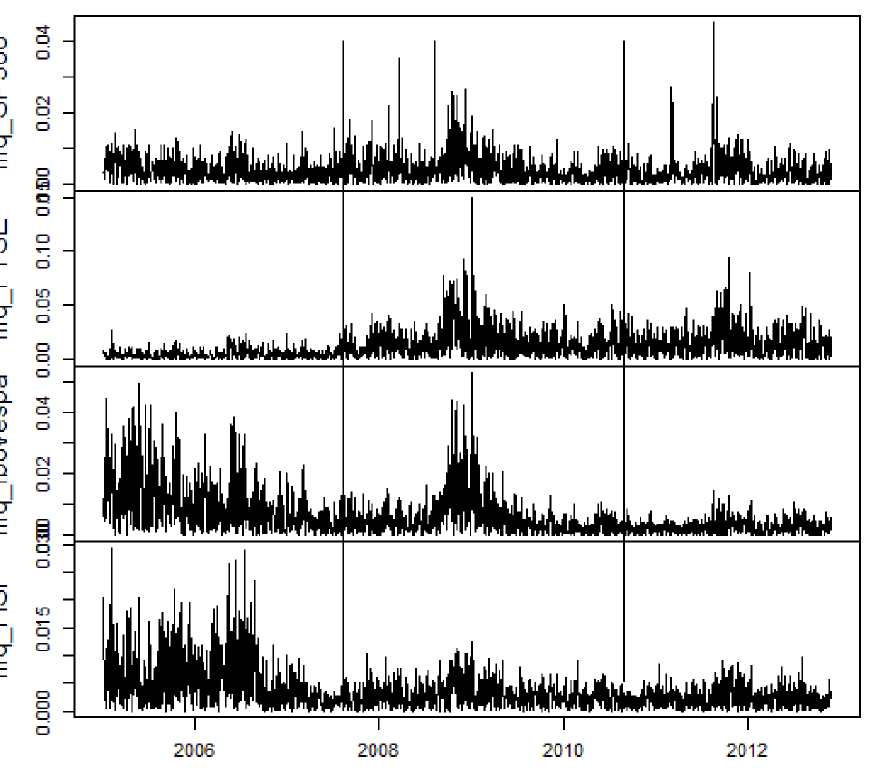
Figure 4. Daily illiquiditiess of S&P500, FTSE100, Ibovespa and HSI from January 2005 to November 2012. Vertical lines represent the subdivision into non-crisis, Sub-prime crisis and Eurozone crisis.